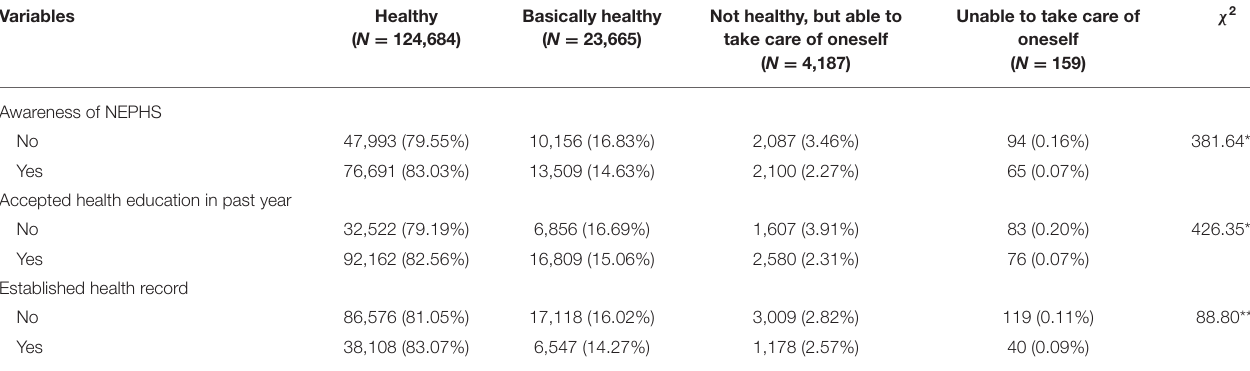
The table reported the frequency and corresponding row percentages for each variable; *** P < 0.01.